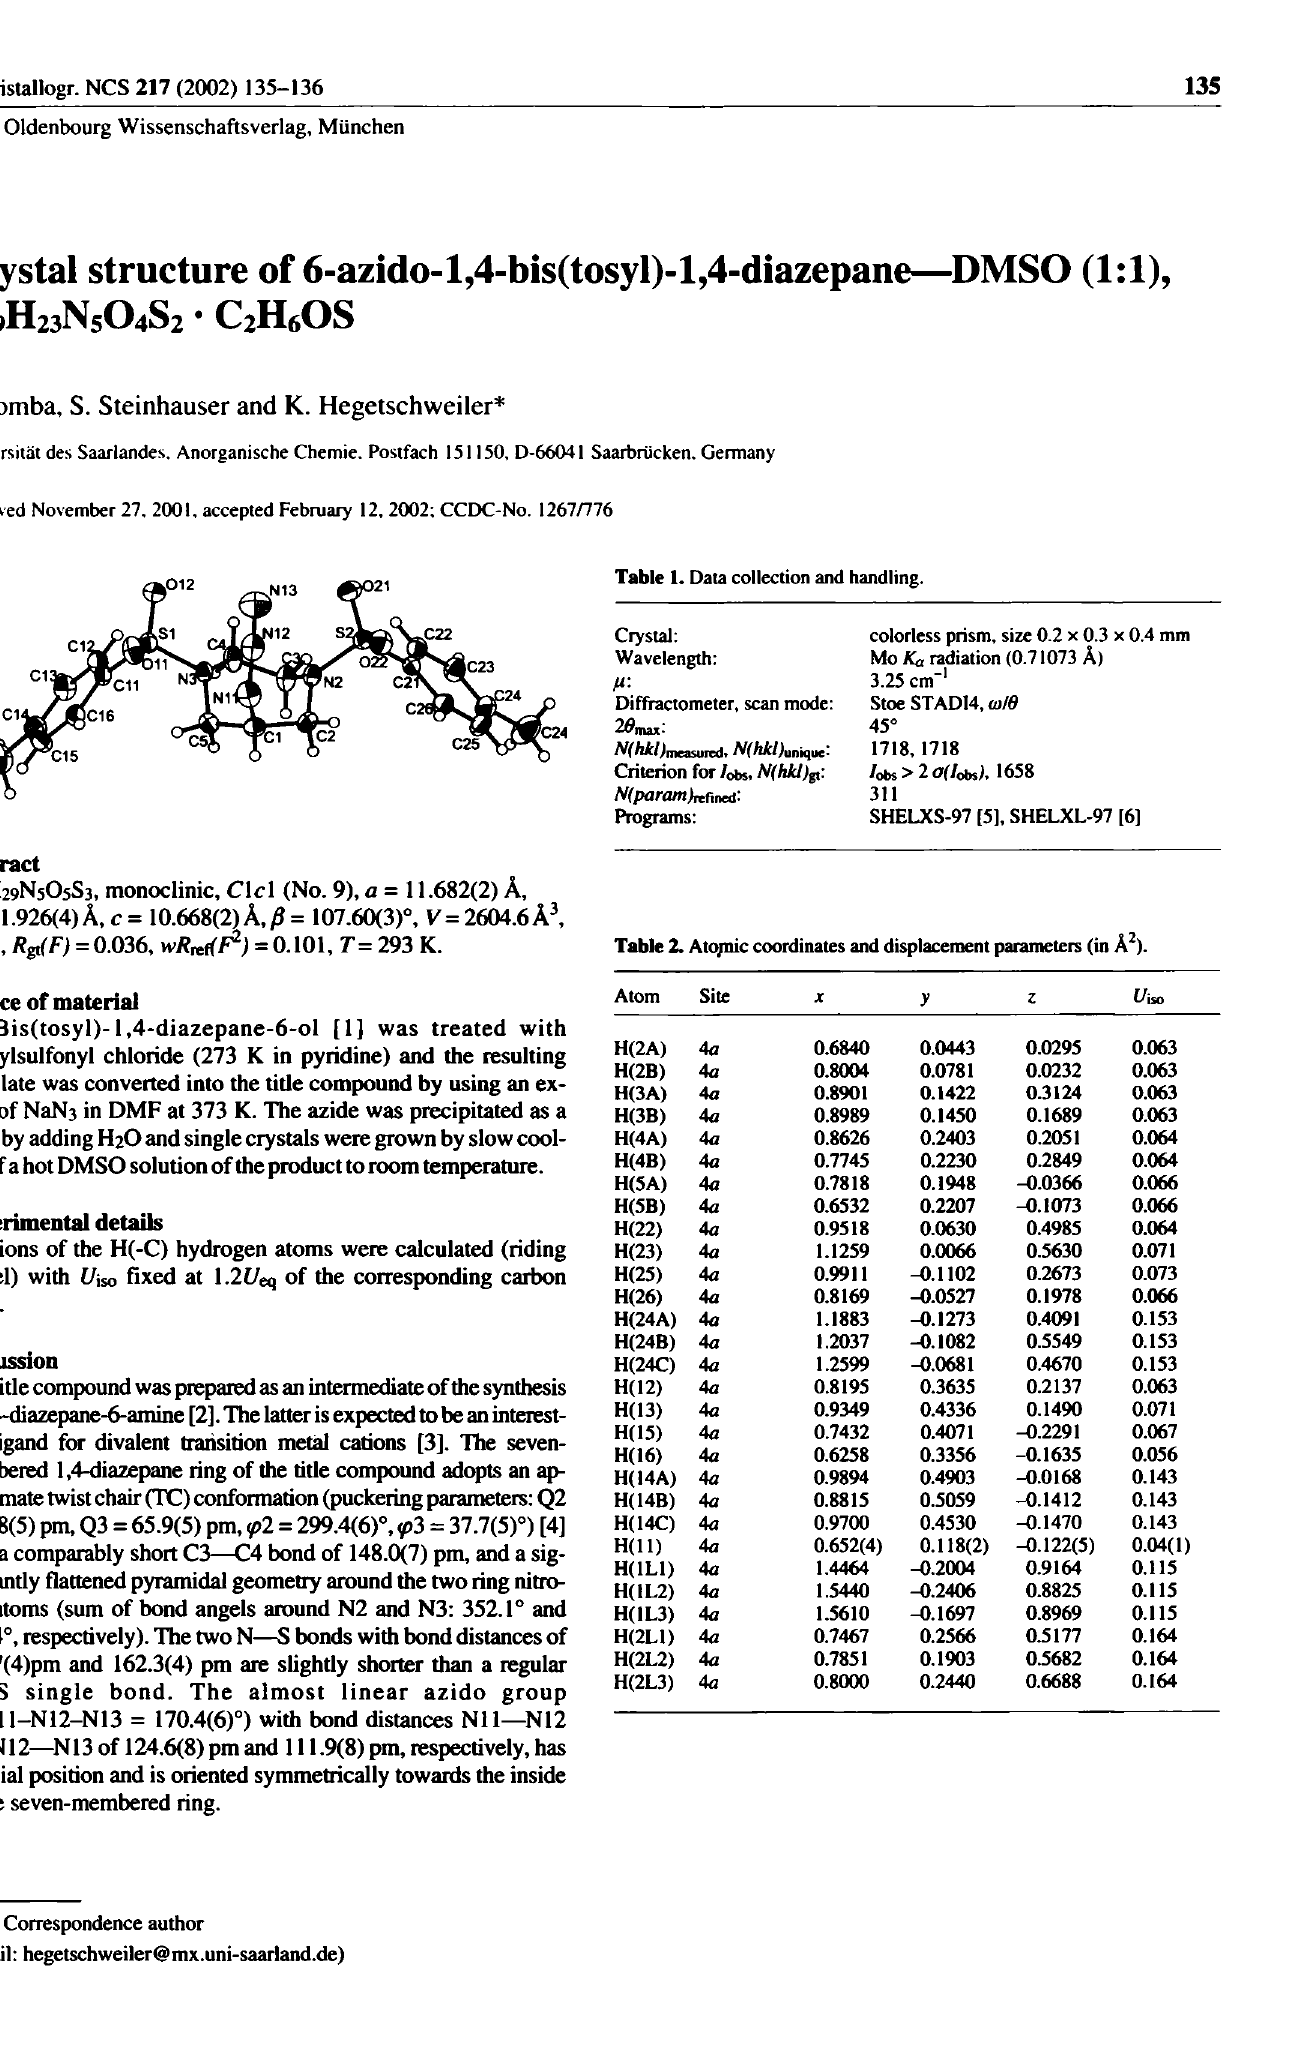
Table 1. Data collection and handling.